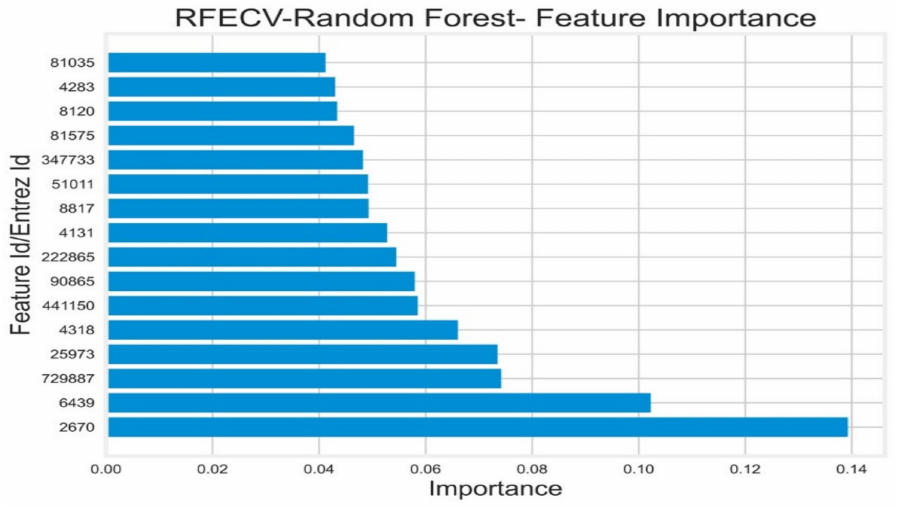
Figure 4. RFECV-Random